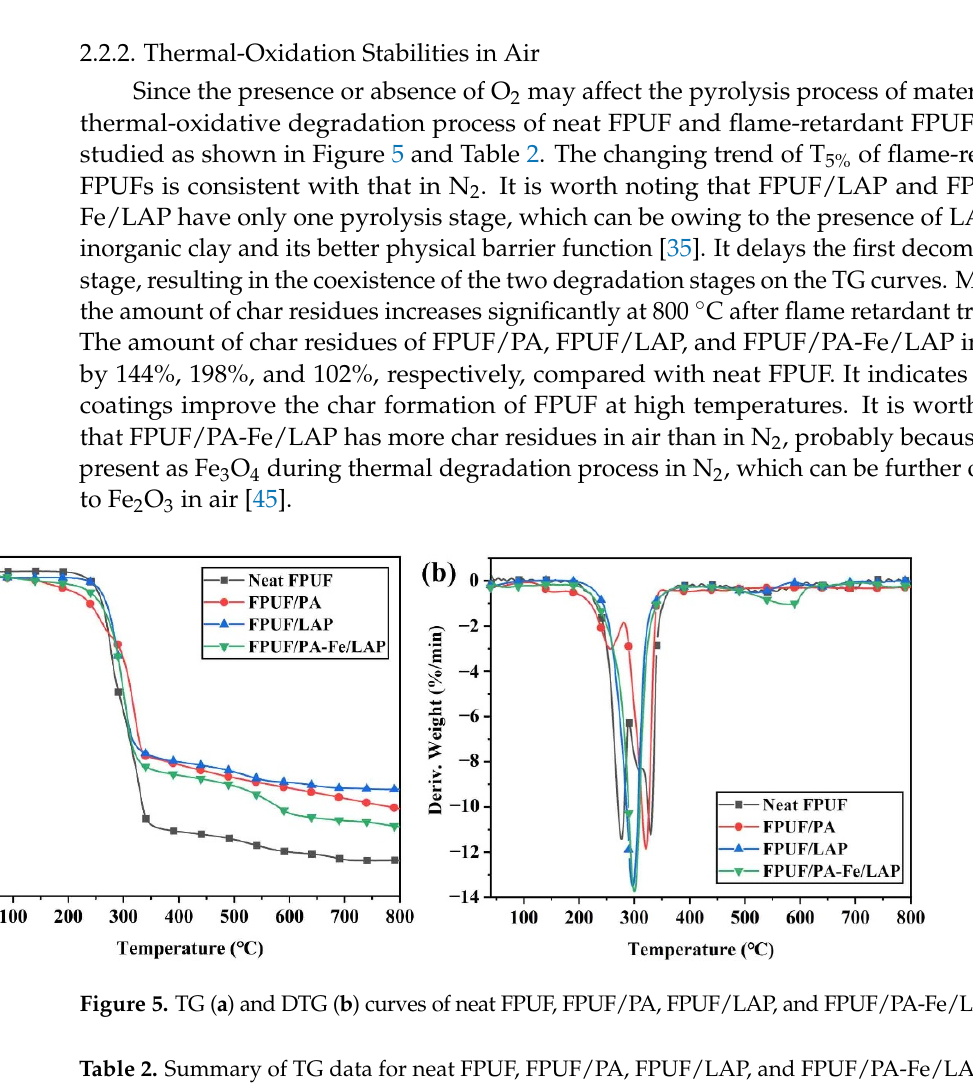
Figure 4. Absorbance intensities of Hydrocarbons ( a ), CO 2 ( b ), -NCO ( c ), CO ( d ), Carbonyl com- pounds ( e ) and Ethers ( f ) from neat FPUF, FPUF/PA, FPUF/LAP, and FPUF/PA-Fe/LAP.